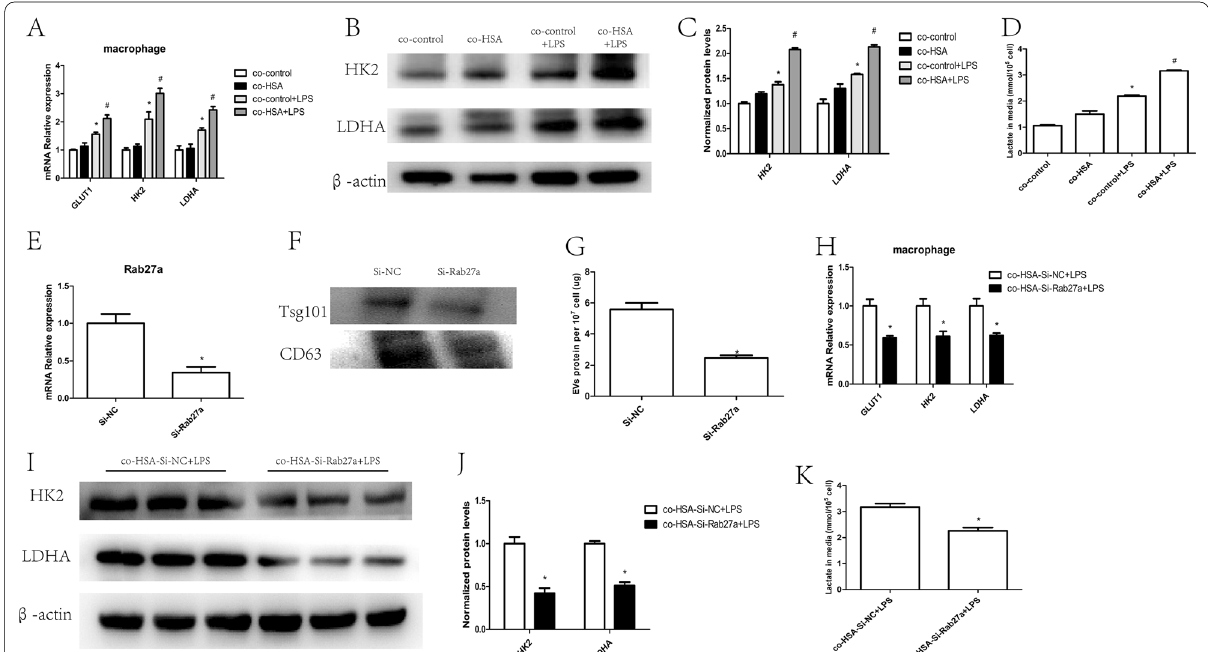
Fig. 2 HSA-treated tubular epithelial cells promoted macrophage glycolysis. Macrophages were co-cultured with HK-2 cells. A mRNA expression of GLUT1, HK2 and LDHA; B , C protein levels of HK2 and LDHA (n 3); D amount of lactate in the macrophage supernatant (n = co-control group; # p < 0.05 vs. the co-control LPS group. HK-2 cells were transfected with Rab27a siRNA: E mRNA levels of Rab27a in HK-2 cells + (n 3); F EV protein levels of CD63 and Tsg101 from the same number of HK-2 cells; G total EV protein from the same number of tubular epithelial = cell-derived EVs (n 3); * p < 0.05 vs. the Si-NC group. Macrophages were co-cultured with HK-2 cells transfected with Rab27a siRNA or Si-NC: H = mRNA levels of GLUT1, HK2 and LDHA (n 3); I , J protein levels of HK2 and LDHA (n 3); K amount of lactate in the macrophage supernatant = = (n 3); * p < 0.05 vs. the co-HSA-Si-NC LPS = +